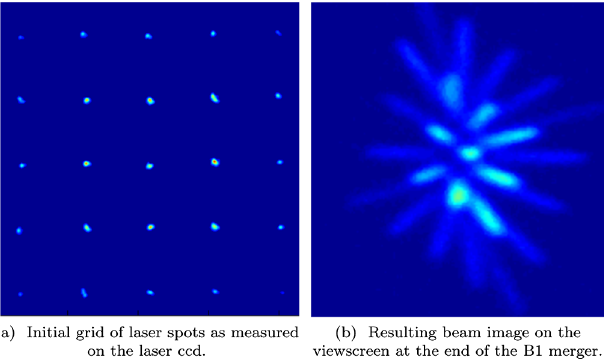
FIG. 9. Alignment check using a grid of laser spots (a) and the resulting beam image on the viewscreen at the end of the B1 merger section (b).